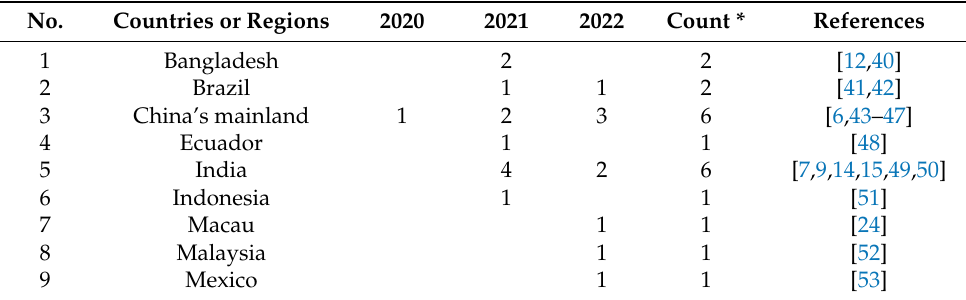
Table 1. Countries or regions of research by the year of publication.